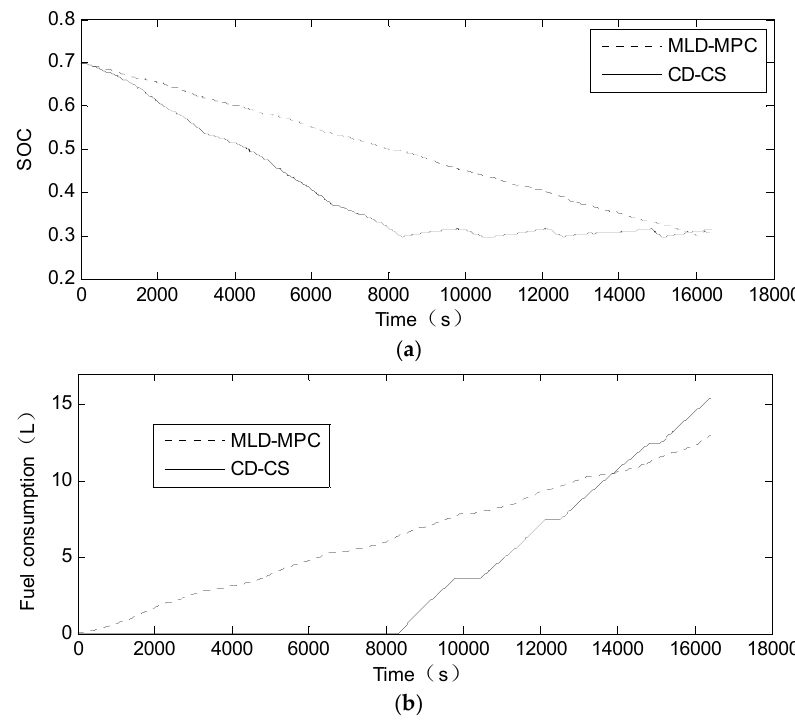
Figure 12. ( a ) comparison of SOC curves of two strategies; and ( b ) comparison of the fuel consumption of two strategies.